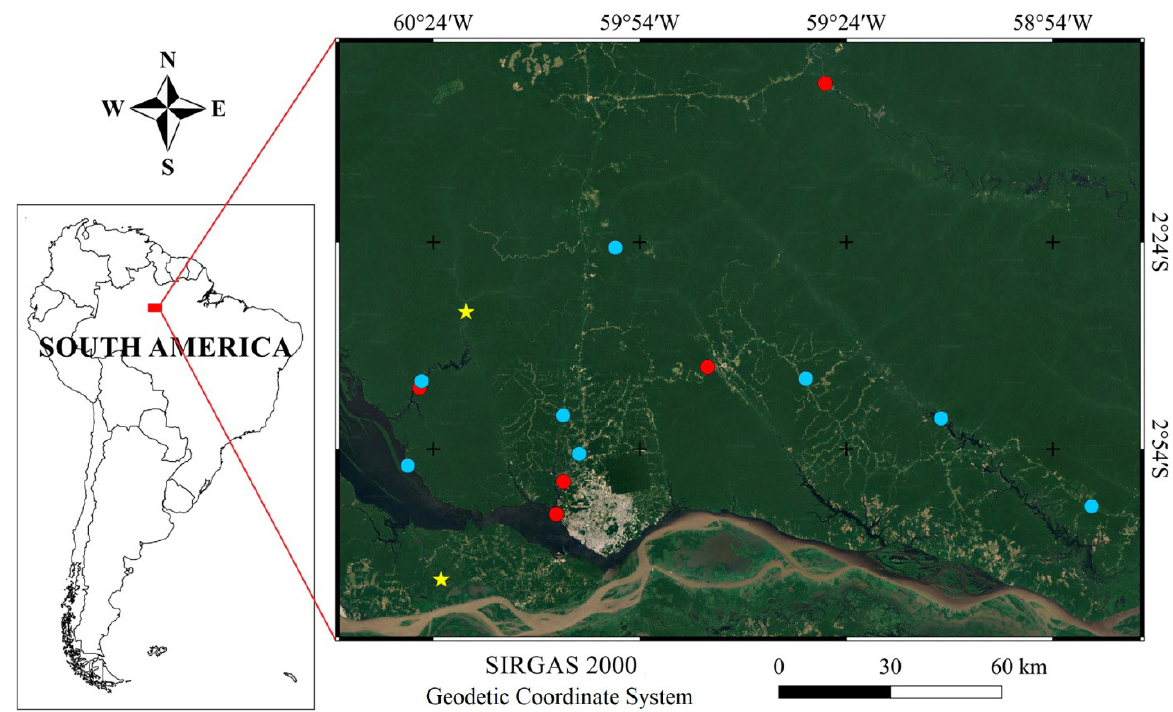
Fig 1. Distribution of Myrcia magna : our records of plants associated with Myrcidris epicharis (yellow stars), and records of plant material deposited in herbaria that bear domatia (blue circles) and without domatia (red circles). Team,